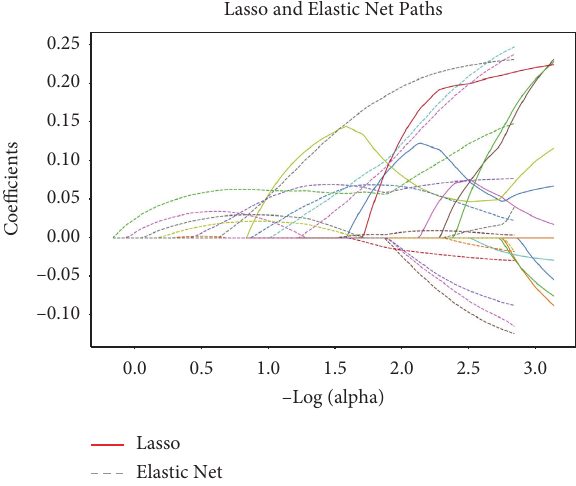
Figure 7: Coefficient paths of LASSO and Elastic Net regression models (let α � λ in LASSO and α � λ